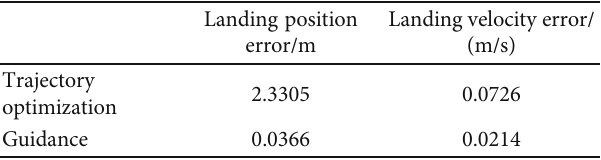
Table 3: Landing errors.